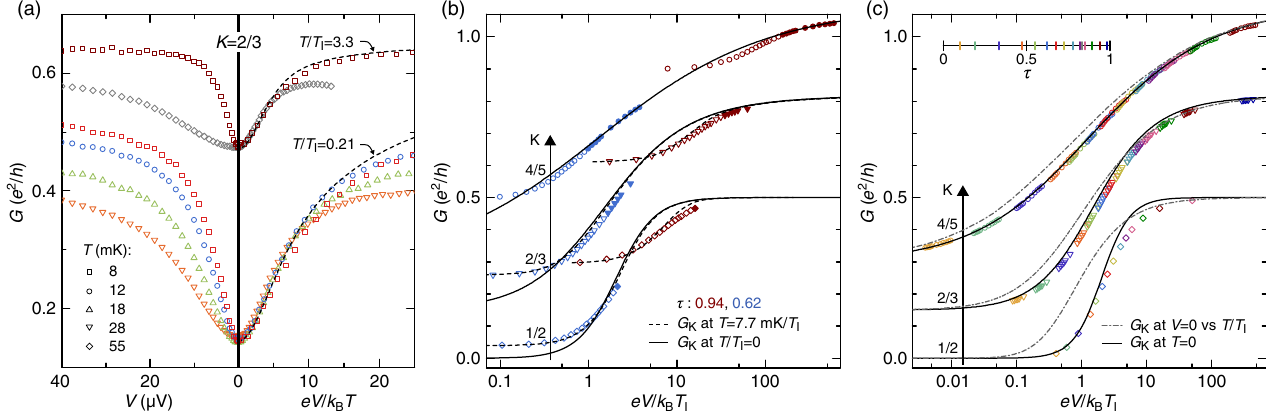
FIG. 4. Out-of-equilibrium conductance renormalization. Symbols in all panels display the measured differential conductance versus several normalizations of the dc bias voltage V . For each device setting of K and τ [color code in (c)], T is separately determined from I G ð V ¼ 0 Þ (Fig. 3). Theoretical predictions are shown for T ¼ 0 [continuous lines; see Refs. [28,29] and Eq. (B6)] and for values of T=T fixed by the corresponding data [dashed lines; see Refs. [28,29] and Eqs. (B1) and (B3)]. In (b),(c), we apply 0.15 vertical shifts I T universality. Data obtained at K ¼ 2 = 3 for several settings of f τ ; T g , between different K ∈ f 1 = 2 ; 2 = 3 ; 4 = 5 g . (a) illustrates the eV=k B T (right side). (b) shows the each corresponding to the same G ð V ¼ 0 Þ (two values shown), are plotted versus V (left side) and eV=k B nontrivial thermal-nonequilibrium crossover as V is increased, for the representative settings τ ¼ 0 . 62 and 0.94 at T ¼ 7 . 7 mK. We T > 12 are signaled by full symbols. show only j eV j < h= 6 RC data points, sufficiently below the high-energy cutoff. Large eV=k B (c) provides a parameter-free comparison between theoretical G T=T I ¼ 0 ð eV=k B T I Þ and data points within j eV j ∈ ½ 12 k B T; h= 6 RC (cid:2) . The K distinct G V=V I ¼ 0 ð T=T I Þ universal scalings at equilibrium are also plotted, versus T=T I , as gray dash-dotted K ( eV ≪ h=RC ≈ 0 . 1 meV), the collapse on a single curve of data sets measured at broadly varying temperatures, differ- ent from each other by a factor of up to 7. The dashed lines represent the theoretical predictions without any additional parameter than the value of T=T fixed by the correspond- I ing zero-bias conductance. The crossover from thermal T ) to nonequilibrium ( eV ≫ k T ) regimes is ( eV ≪ k B B further investigated in Fig. 4(b), for different K ∈ f 1 = 2 ; 2 = 3 ; 4 = 5 g . At a finite temperature, the full